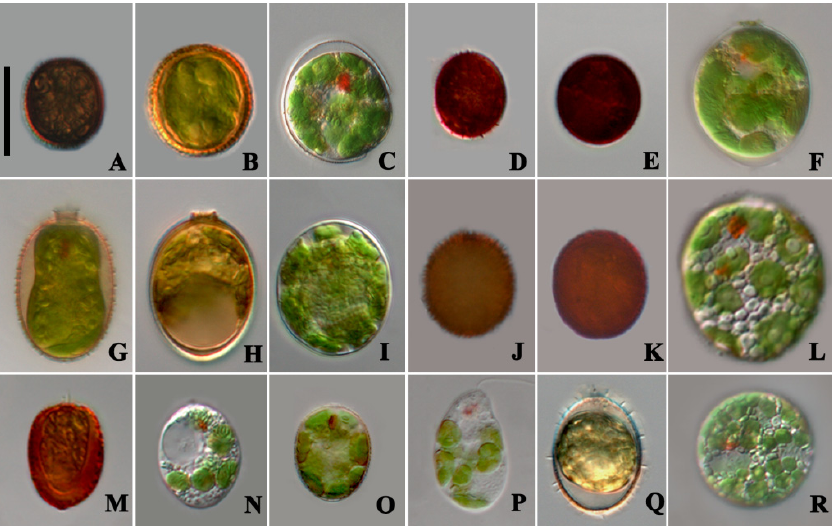
Figure 3. Morphology of Trachelomonas strains in this study: ( A – L ) each species includes: morphology of lorica in the field (left), morphology of lorica in culture (middle), protoplast morphology (right); ( A – C ) Trachelomonas sp. strain SHNUS12C2; ( D – F ) Trachelomonas sp. strain SHNUS26A3; ( G – I ) T. hispida strain SHNUQ1D6; ( J – L ) T. cf. sydneyensis var. minima strain SHNUC1D1; ( M , N ) Morphology of Trachelomonas sp. strain SHNUS25D1 in culture; ( O , P ) morphology of Trachelomonas sp. strain SHNUN16B1 in culture; ( Q ) morphology of Trachelomonas sp. strain SHNUS30A1 in culture; and ( R ) protoplast morphology of Trachelomonas sp.strain SHNUC2D. Species are all in the same scale, scale bar 20 μ m.